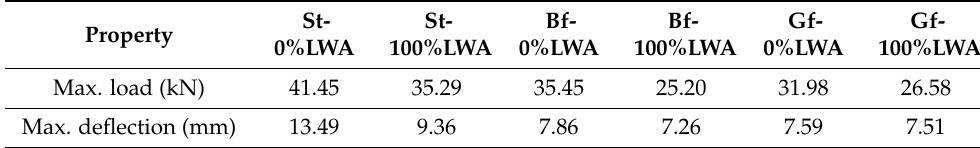
Table 8. Average values of the maximum deflection at the maximum